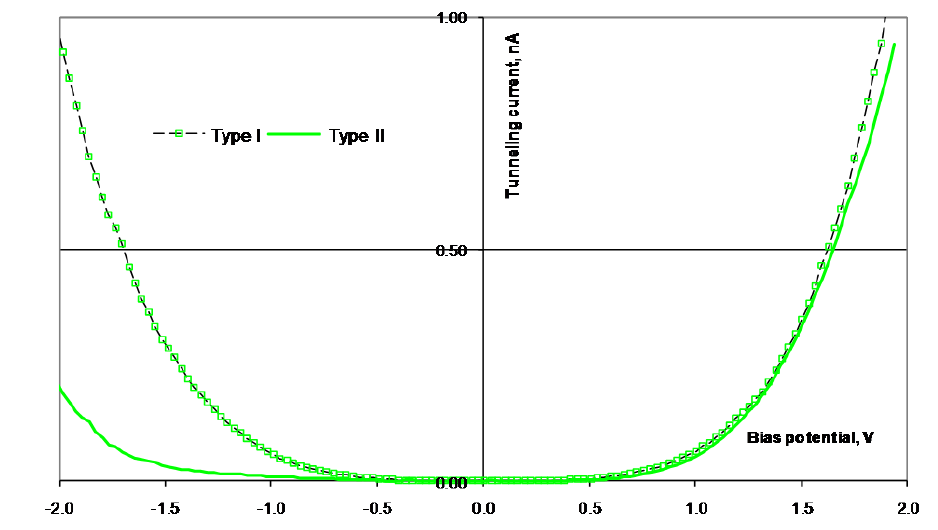
Figure 10. I(U) curves obtained from STS scans performed on the surface of Ni Co Si B . The absolute value of the tunneling current is used. 25 50 15 10